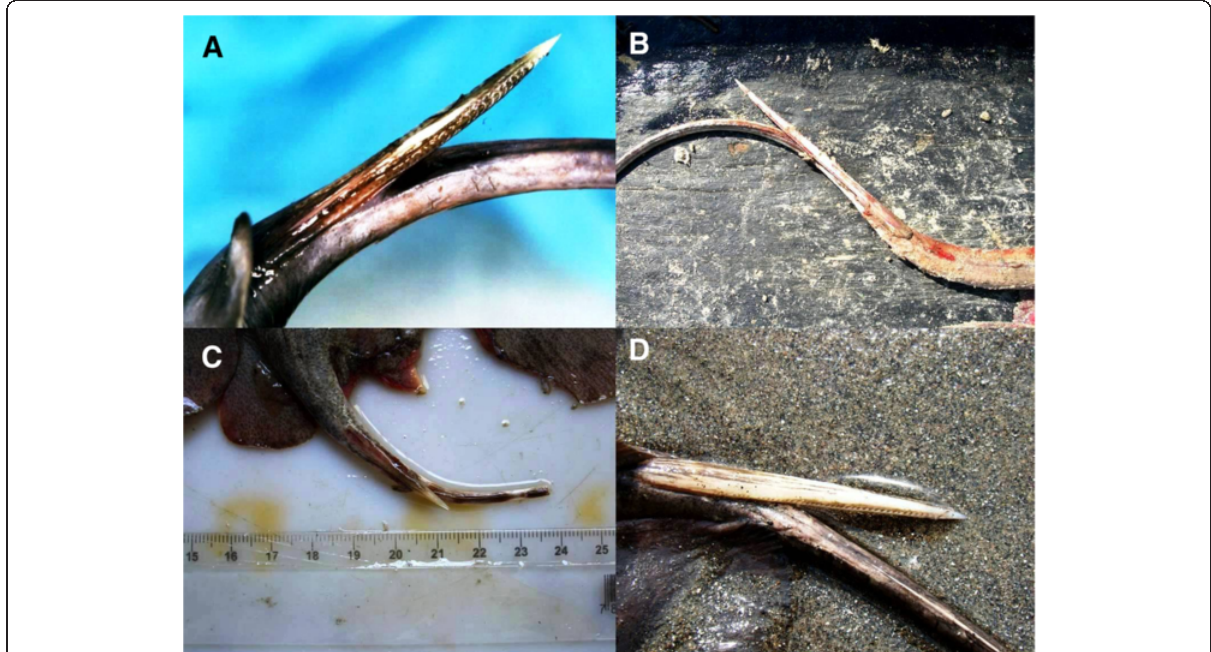
Figure 3 Note the bony structures and serrated edges of stingers of the following species: (A) Aetobatus narinari ; (B) Dasyatis guttata ; (C) Gymnura sp.; and (D) Rhinoptera bonasus . Photos by: Vidal Haddad Junior.